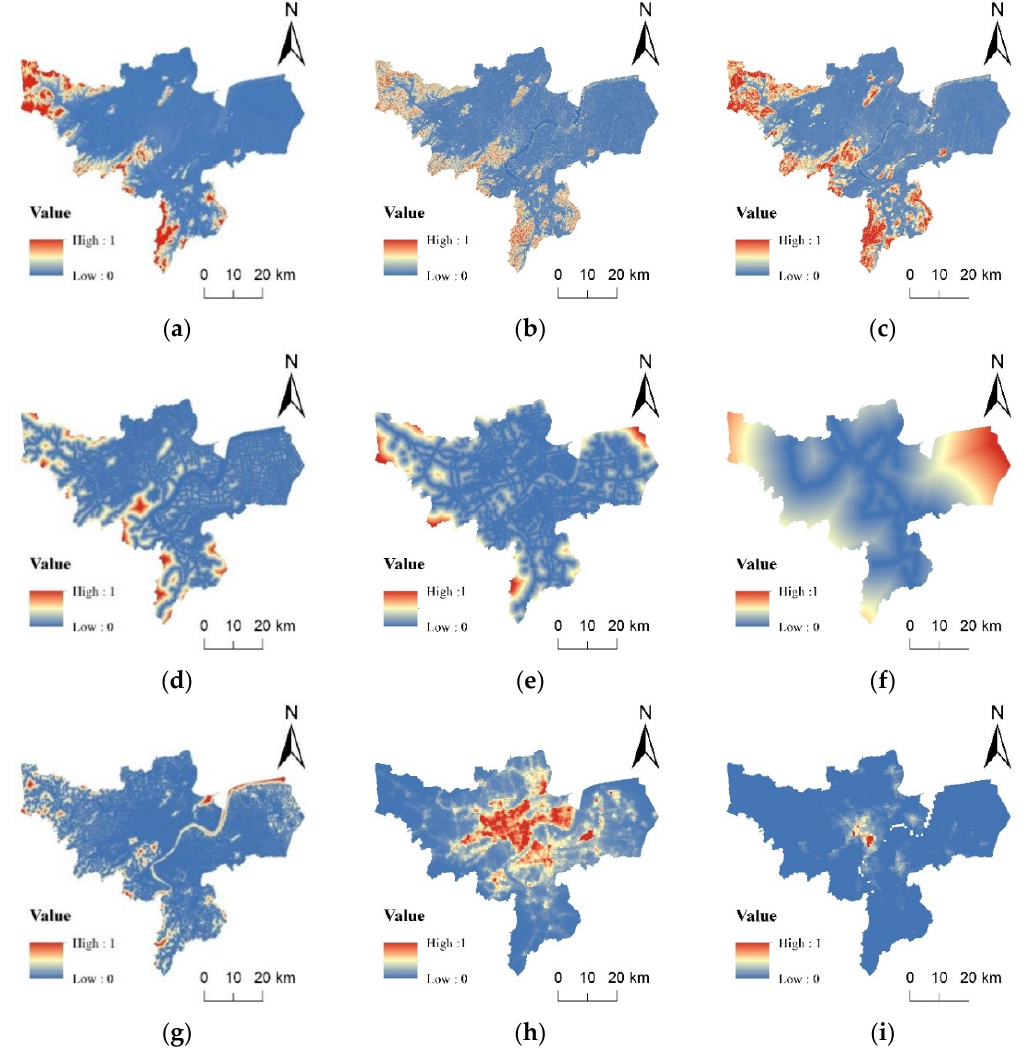
Figure 2. Data of driving factors: ( a ) elevation; ( b ) slope; ( c ) topographic relief; ( d ) distance to rivers; ( e ) distance to roads; ( f ) distance to railways; ( g ) distance to residential area; ( h ) night light data; ( i ) population